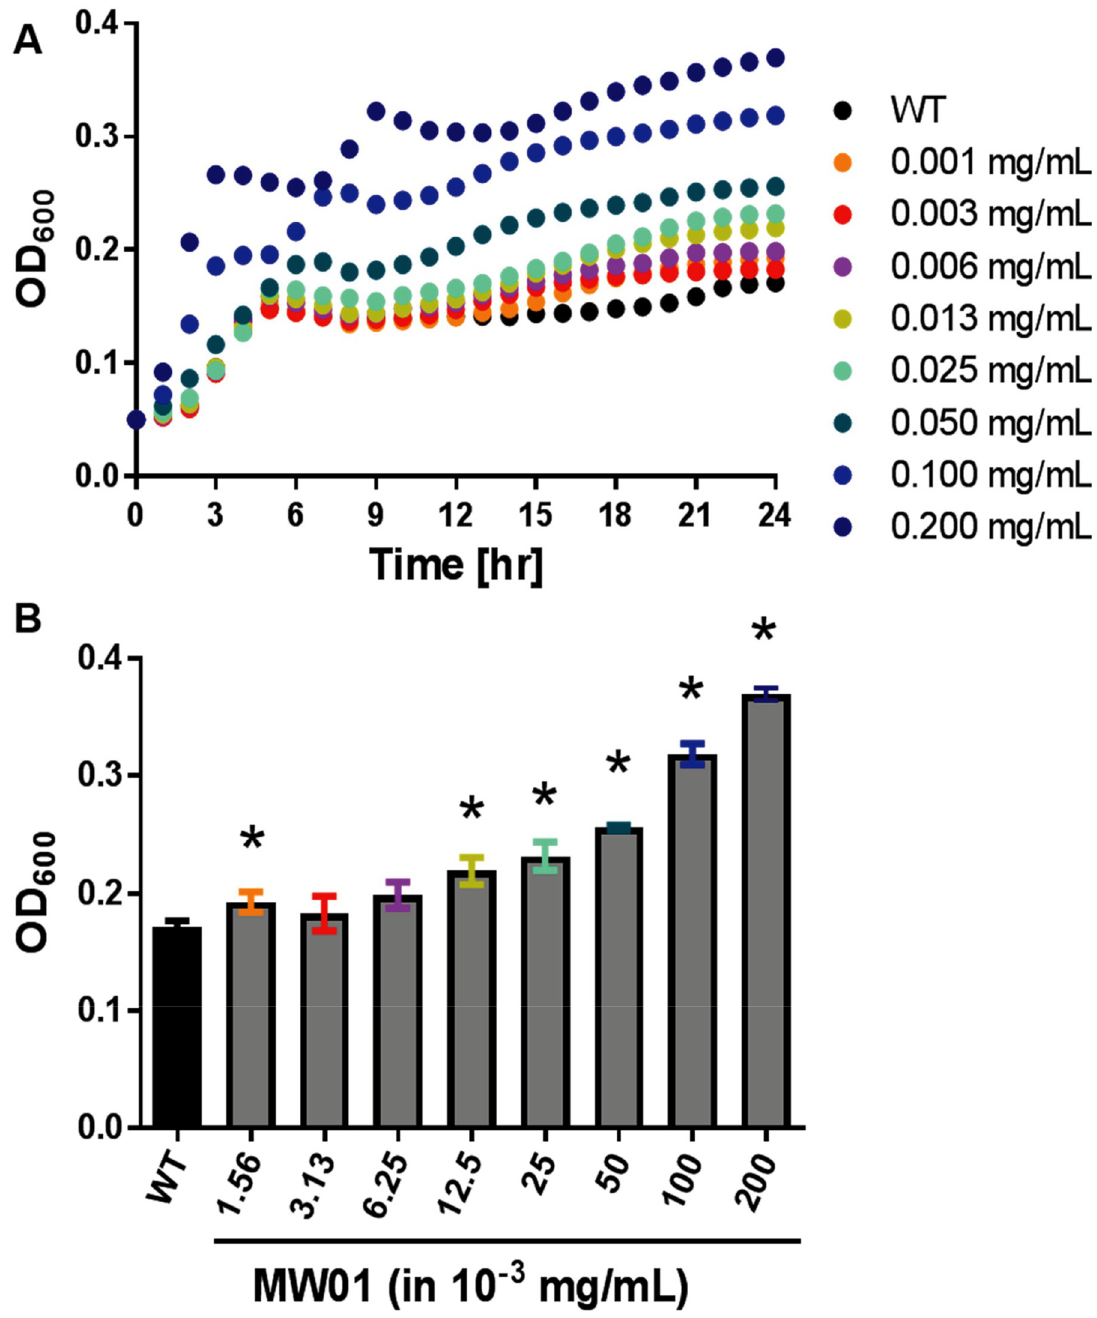
Fig 5. Impact of MW01 on V . cholerae growth in MM Glu . Assays were carried out at 30˚C in microtiter plates. Optical density measurements at 600 nm (OD 600 ) reflect the ability of V . cholerae to grow (both as planktonic and biofilm cells) in minimal medium supplemented with 0.5% wt/vol glucose (MM Glu ). Data are shown for a wild-type V . cholerae (WT) alone or in the presence of MW01, as (A) bacteria grow over time in 96-well plate cultures and (B) at the 24-hour mark of the growth culture. Bacteria were exposed to MW01 at concentrations varying from 0.001- to 0.200-mg/mL. Conditions were tested in triplicate in each experiment, and three experimental replicates were performed on separate